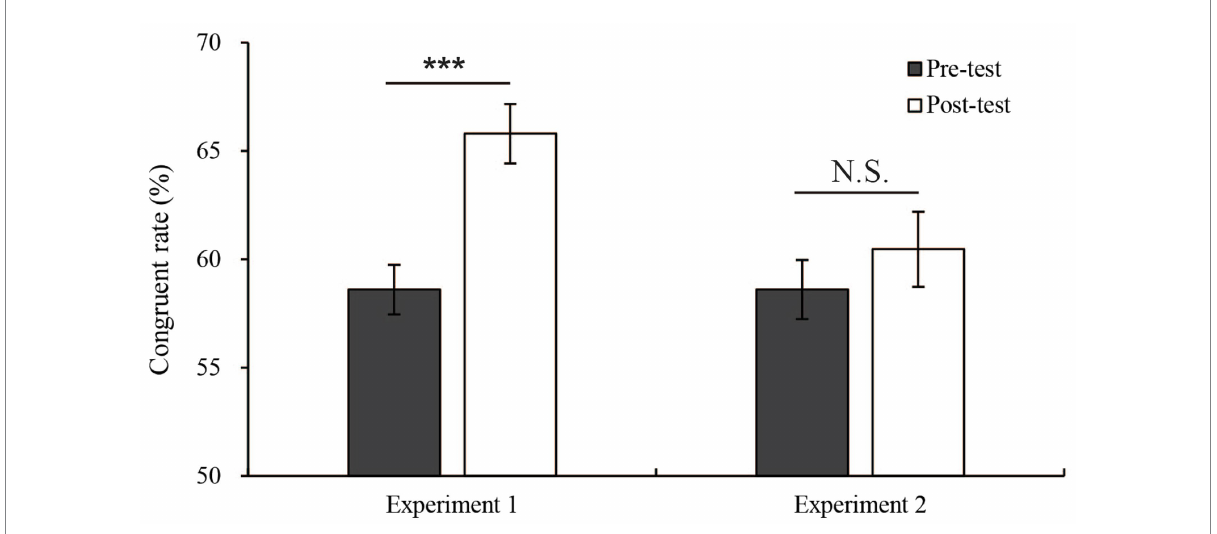
FIGURE 4 Mean congruent response rates in the pre-test and post-test free-choice trials in Experiments 1 and 2. Error bars show the standard error of mean. *** p < 0.001. ** p < 0.01. * p < 0.05. N.S. indicates a nonsignificant difference.